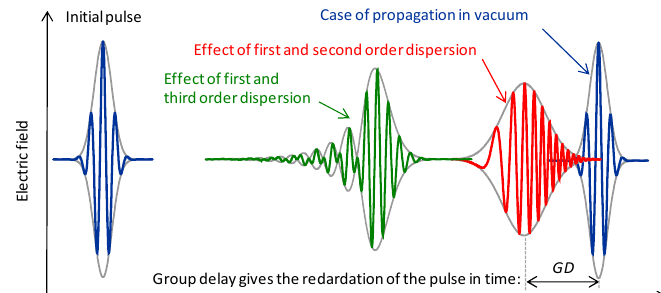
Figure 1. Schematic temporal effect of the first three phase